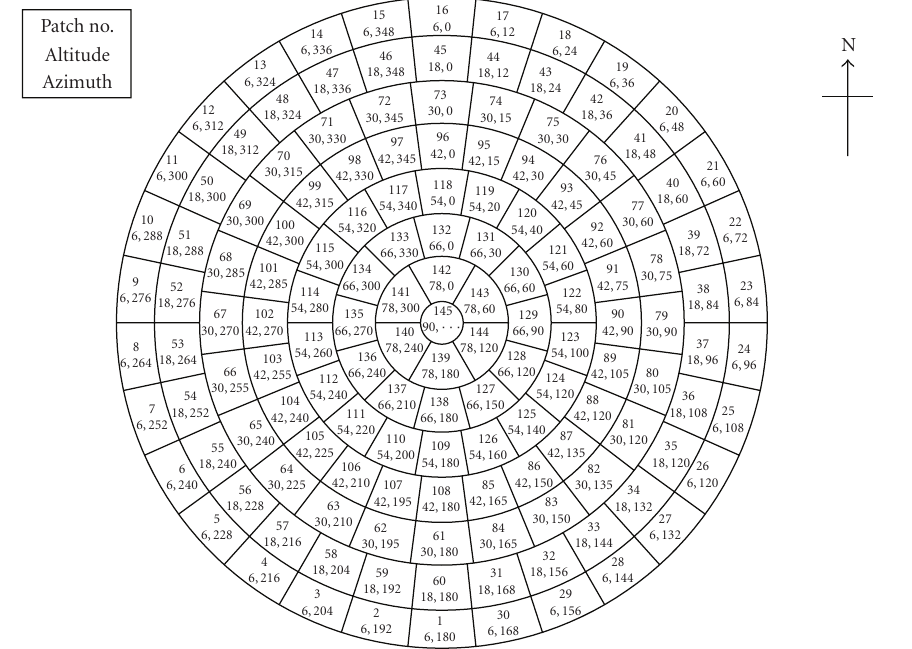
Figure 1: The measurement points for the sky scanner.